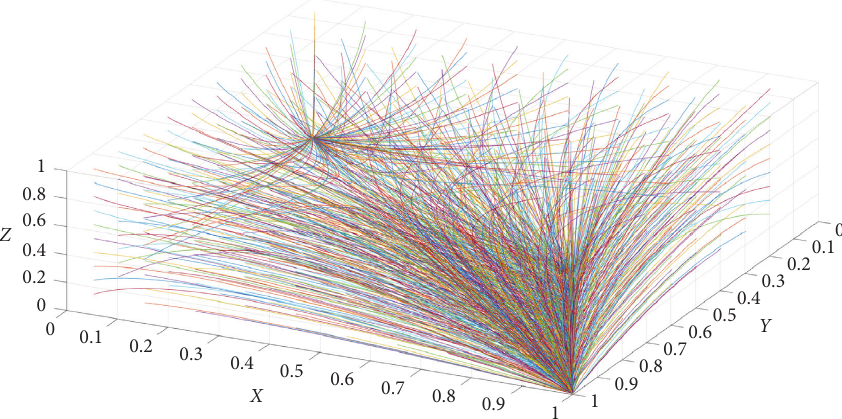
Figure 3: Evolution paths of scenario 3.